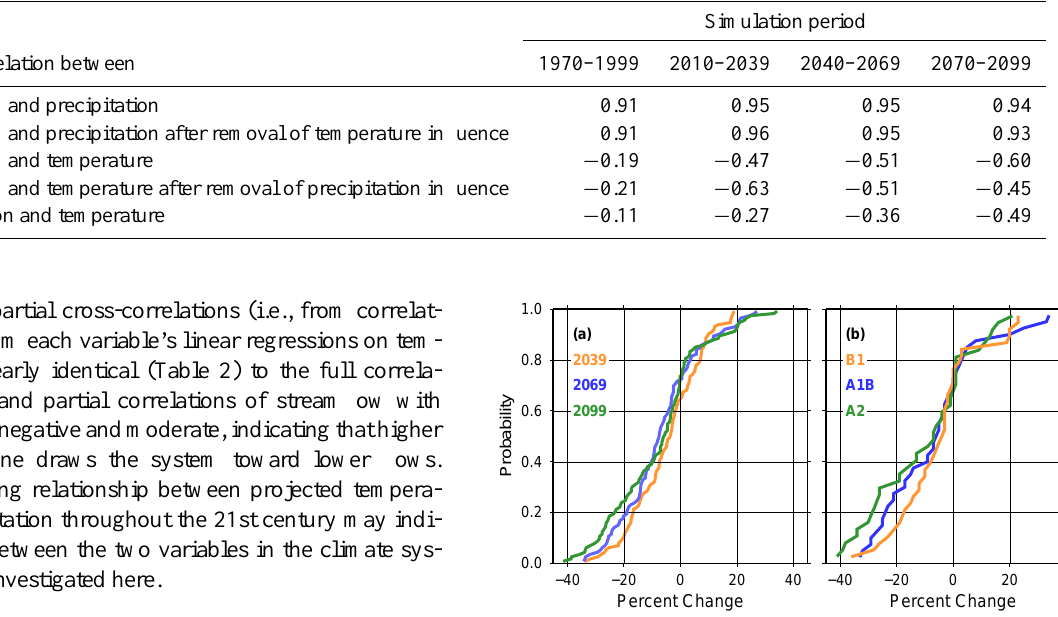
Fig. 7. (a) Distribution of projected changes in average streamflow for 30-yr periods ending in 2039, 2069 and 2099, relative to sim- ulated historical (1970–1999) average flow from each downscaled projection. Positive values are flow increases. (b) Distribution of projected relative flow changes for 2070–2099 for each SRES emis- sions